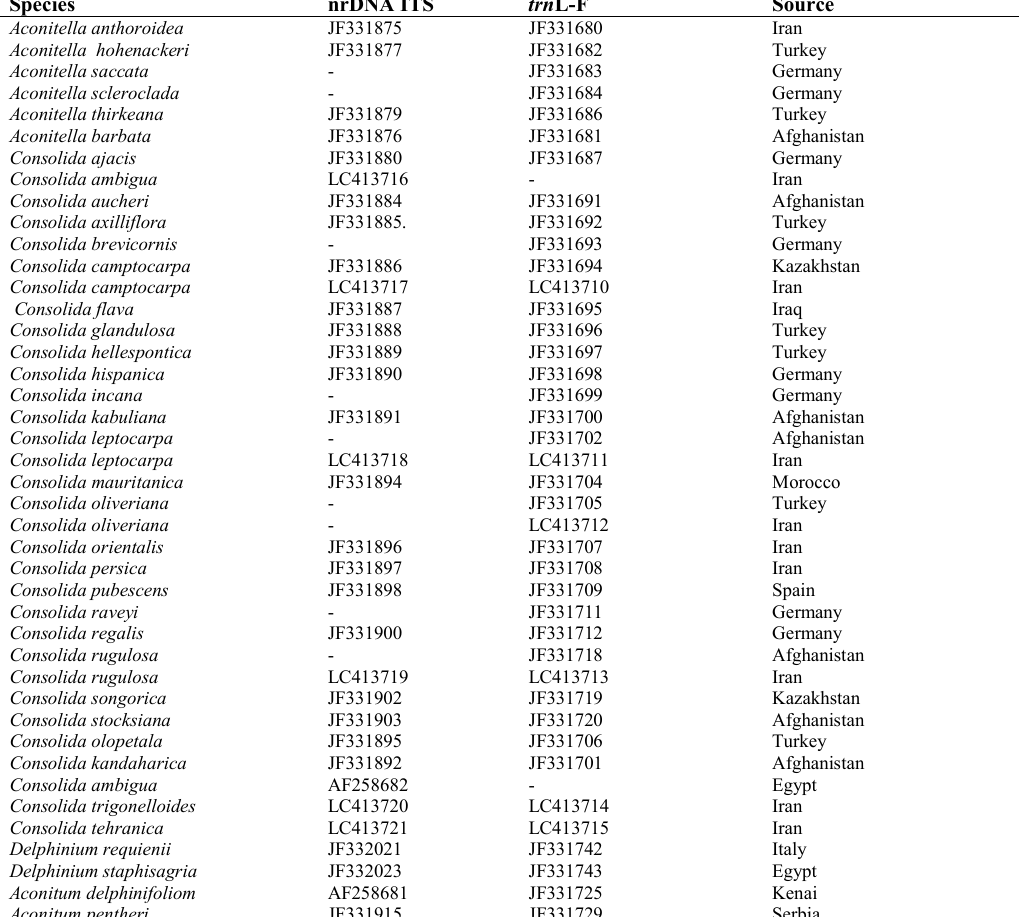
Table 1. GenBank accession number and source for sample used in the study Species nrDNA ITS